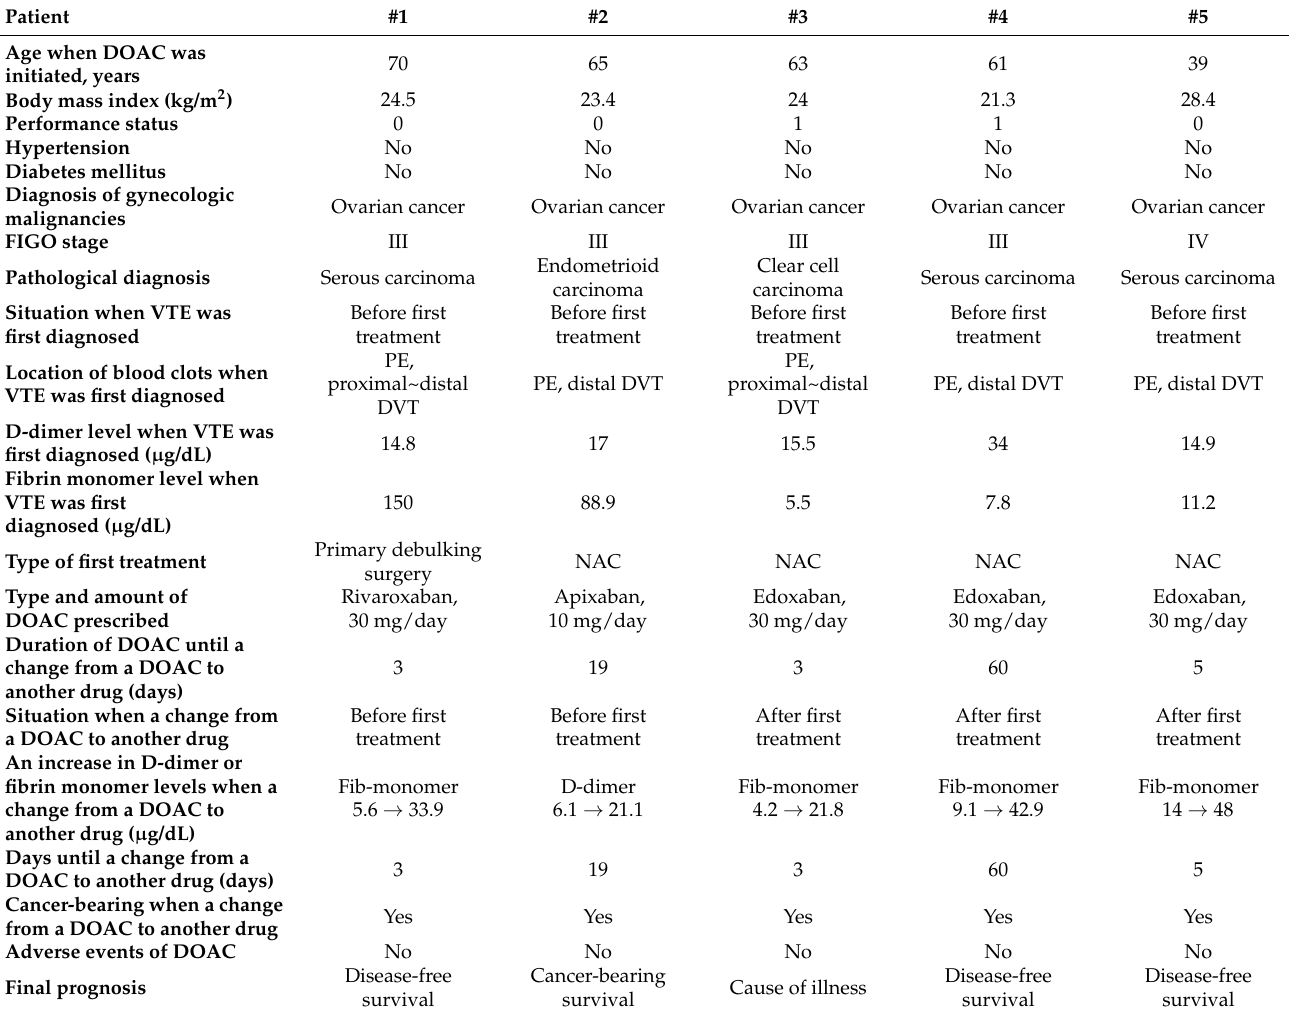
Table 4. Characteristics of participants who changed